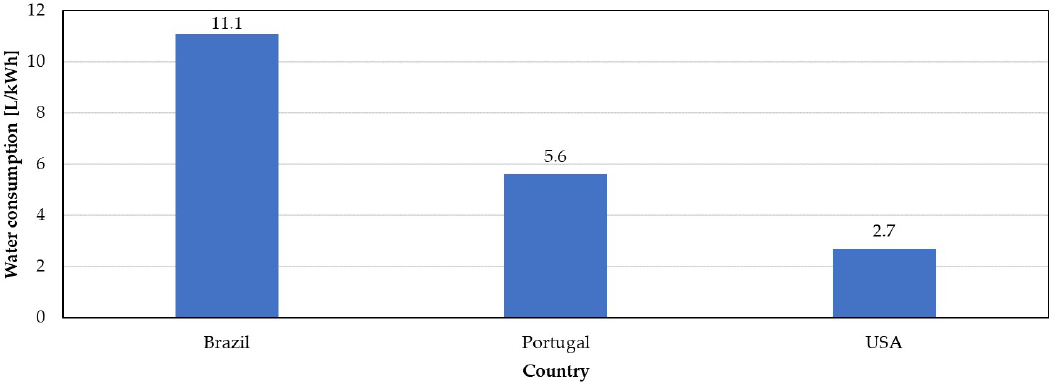
Figure 7. Water consumption (L/kWh).